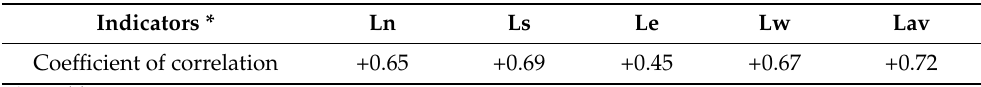
Table 9. The relationship between DBH and the distance to the nearest trees in the directions of the cardinal points. Indicators * Ln Ls Le Lw Lav Coefficient of correlation +0.65 +0.69 +0.45 +0.67